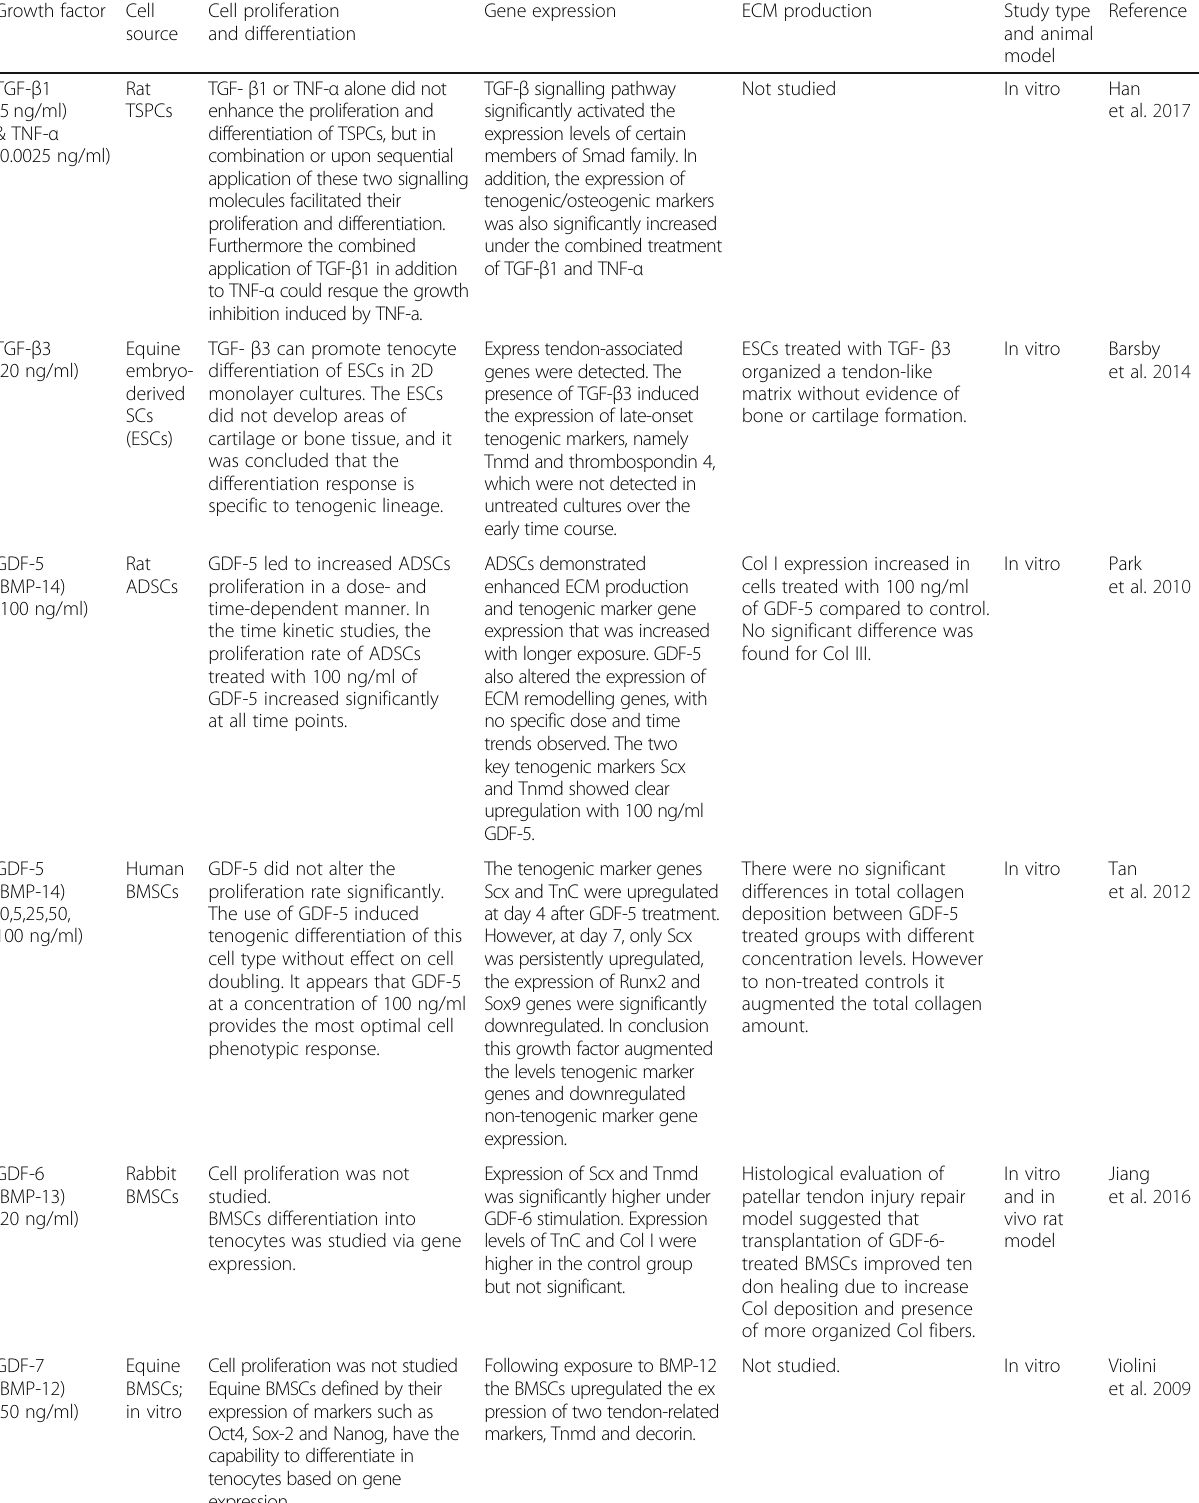
Table 1 Pro-tenogenic growth factors Growth factor Cell